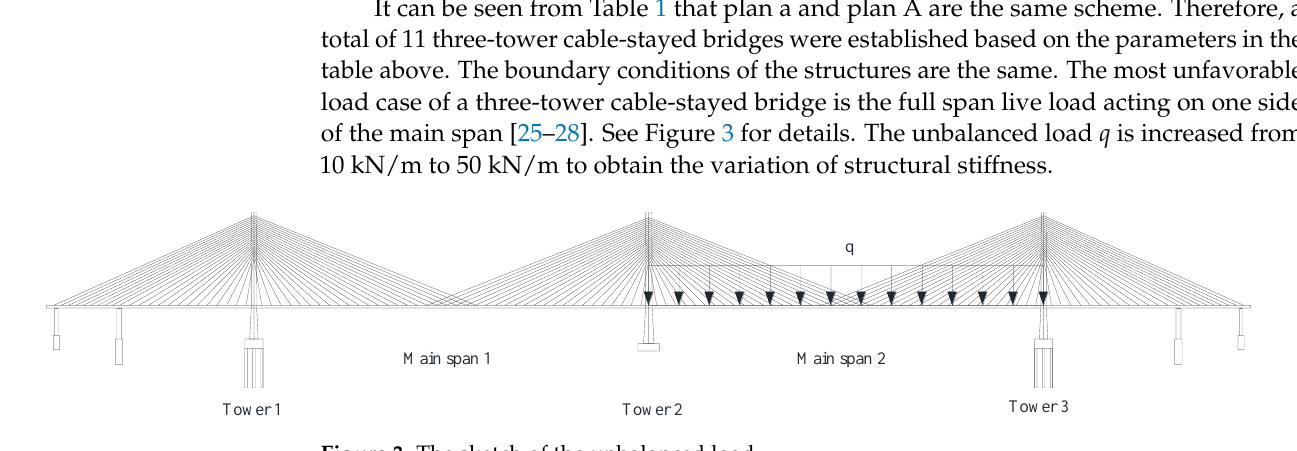
Figure 3. The sketch of the unbalanced load.